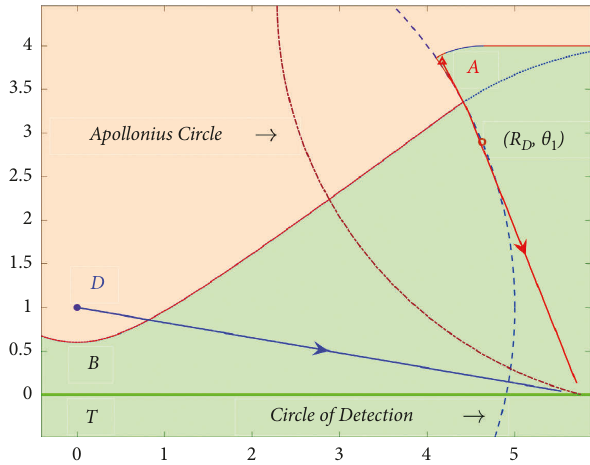
Figure 18: The situation when the attacker loses the